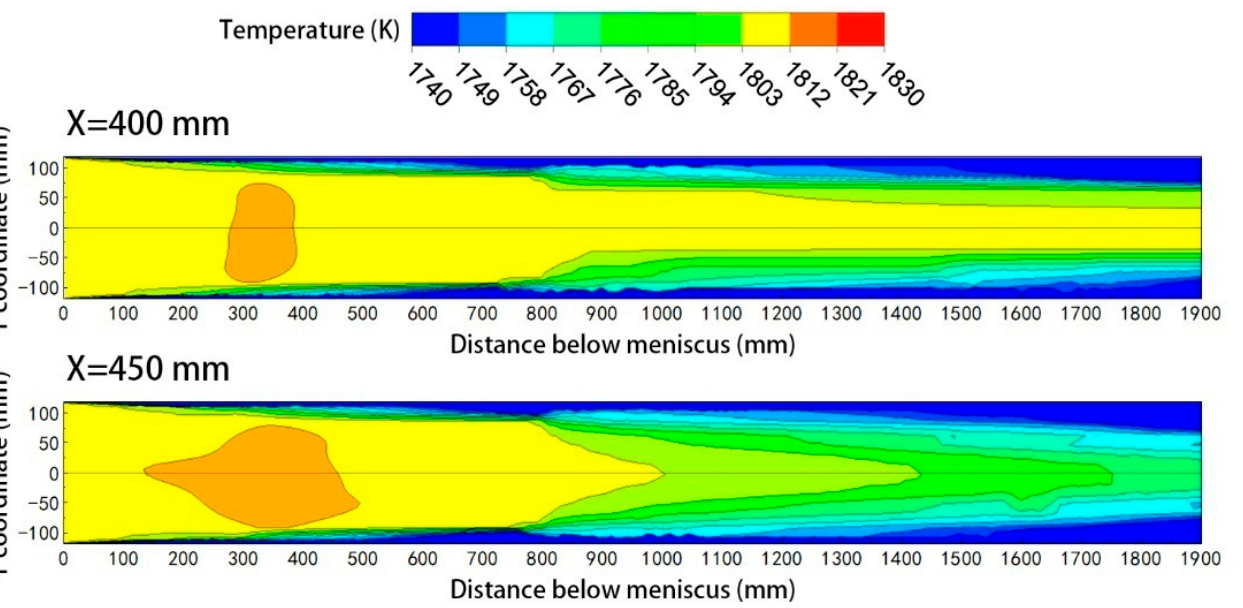
Figure 10. The contour of temperature in the different X